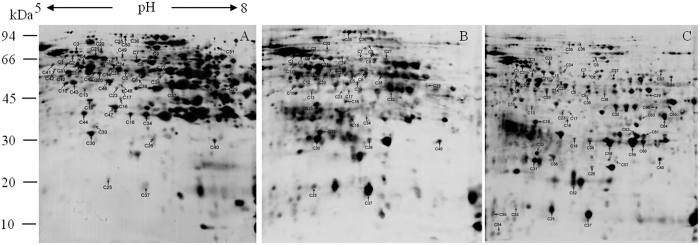
Two-dimensional (2D) immunoblots using antidinitrophenyl hydrazone antibody to detect carbonylated embryo proteins in 0-d (A), 3-d (B), and 4-d (C) aged rice seeds after imbibition for 48 h. Total 500 μg protein were numbered in a preparative 2D electrophoresis gel and excised for MS/MS analysis, corresponding to the proteins in Tables 1, 2 and 3. Number on the left represents the apparent molecular mass. Number above the gels represents the pI of separated protein spot. (C) Carbonylated spot.